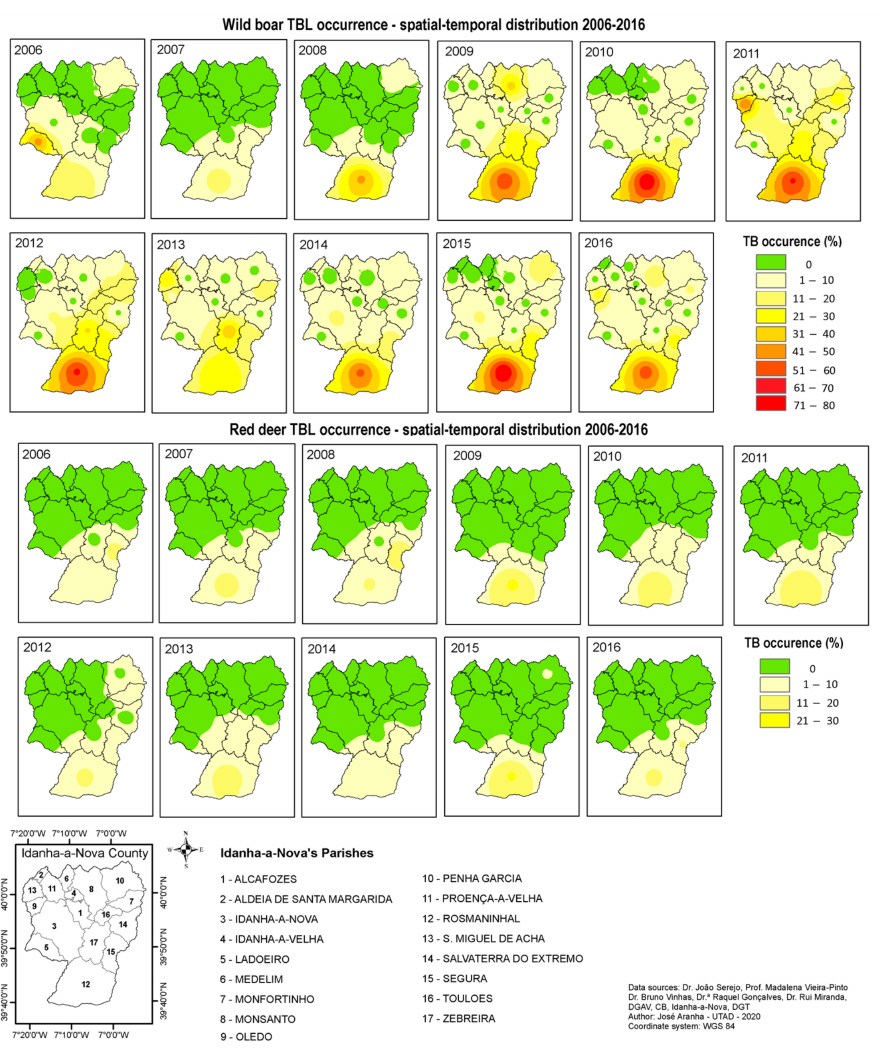
Figure 8. TB occurrence spatial–temporal distribution within Idanha-a-Nova county from 2006 to 2016. ( top ): wild boar; ( bottom ): red